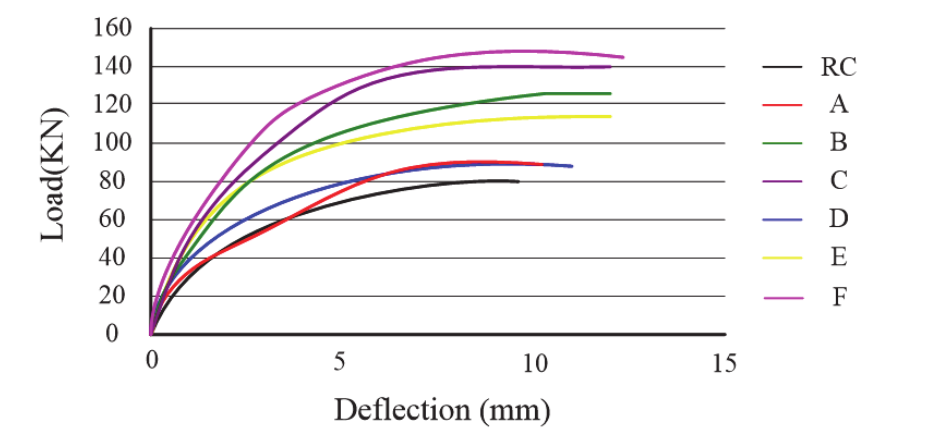
Figure 5: The load-deflection curve of different beams